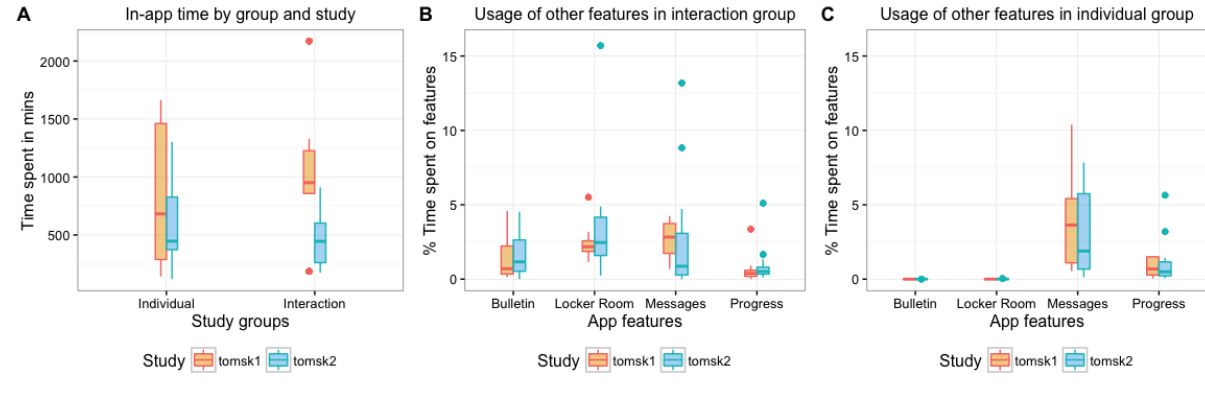
Figure 4. App usage by group and study. (A) Total time (in min) spent by user in the app during the experiment, (B) Usage of the app features in the interaction group, and (C) Usage of the app features in the individual group, % from total time spent in the